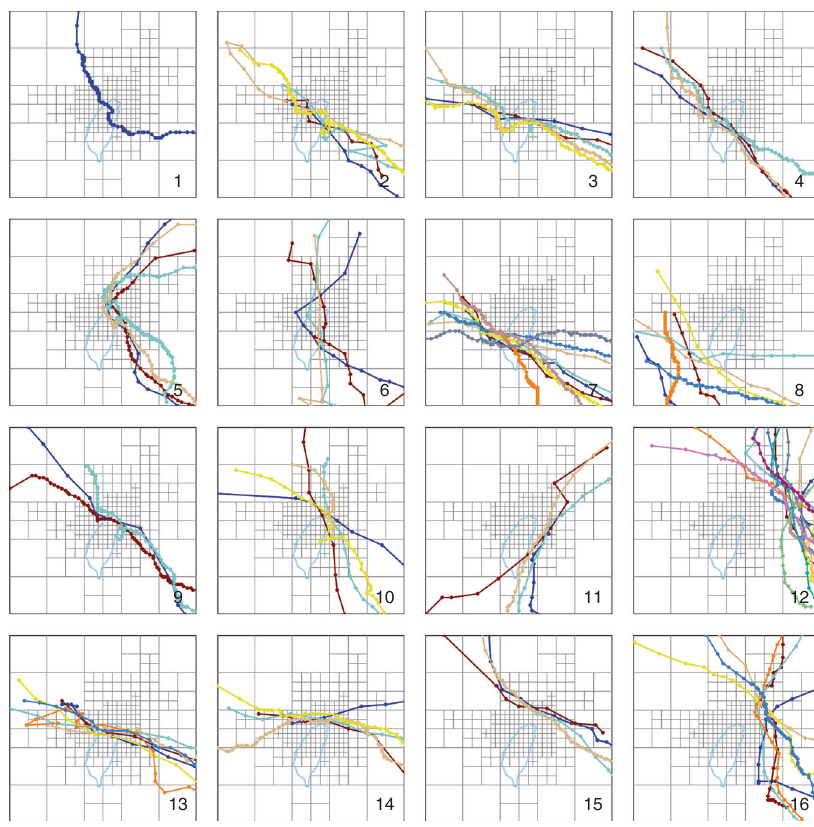
Fig. 3 Individual typhoon tracks clustered in the 4 × 4 self-organizing map. Each typhon track in a cluster is plotted over grid cells. Different colors plot different typhoon